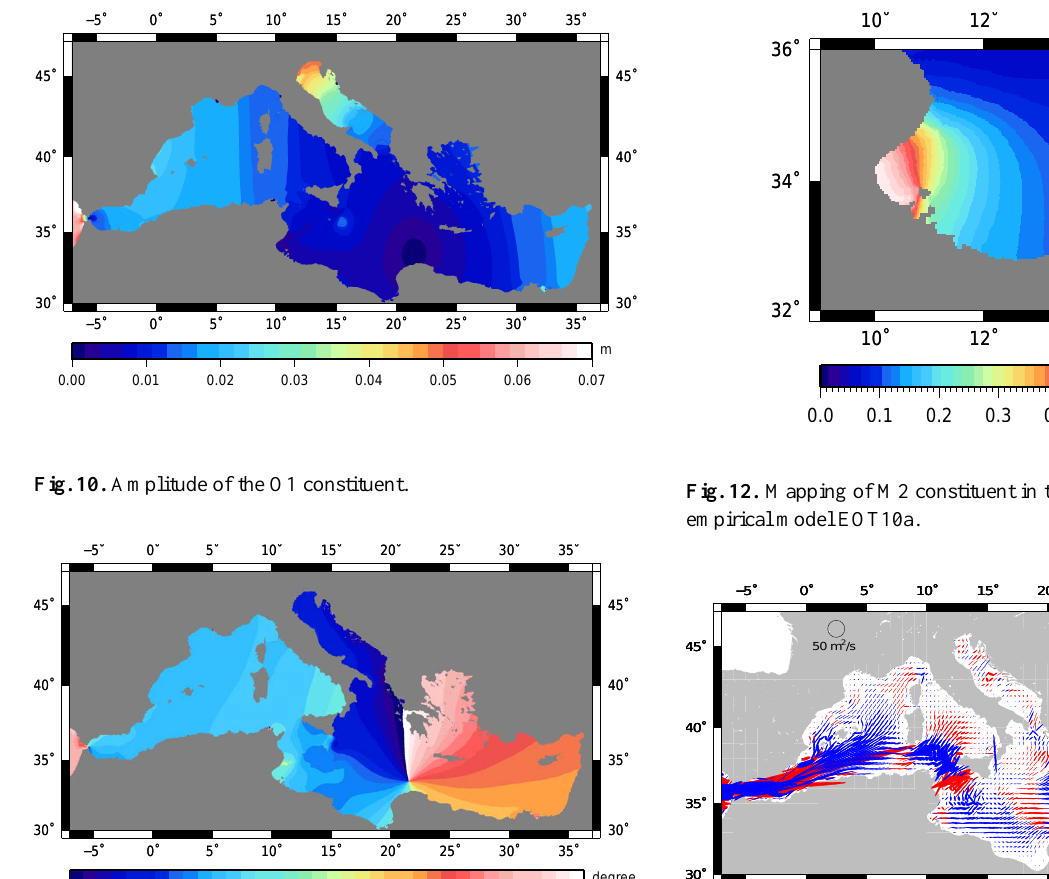
Fig.11. PhaseoftheO1constituent(degreesrelativetoUTC)